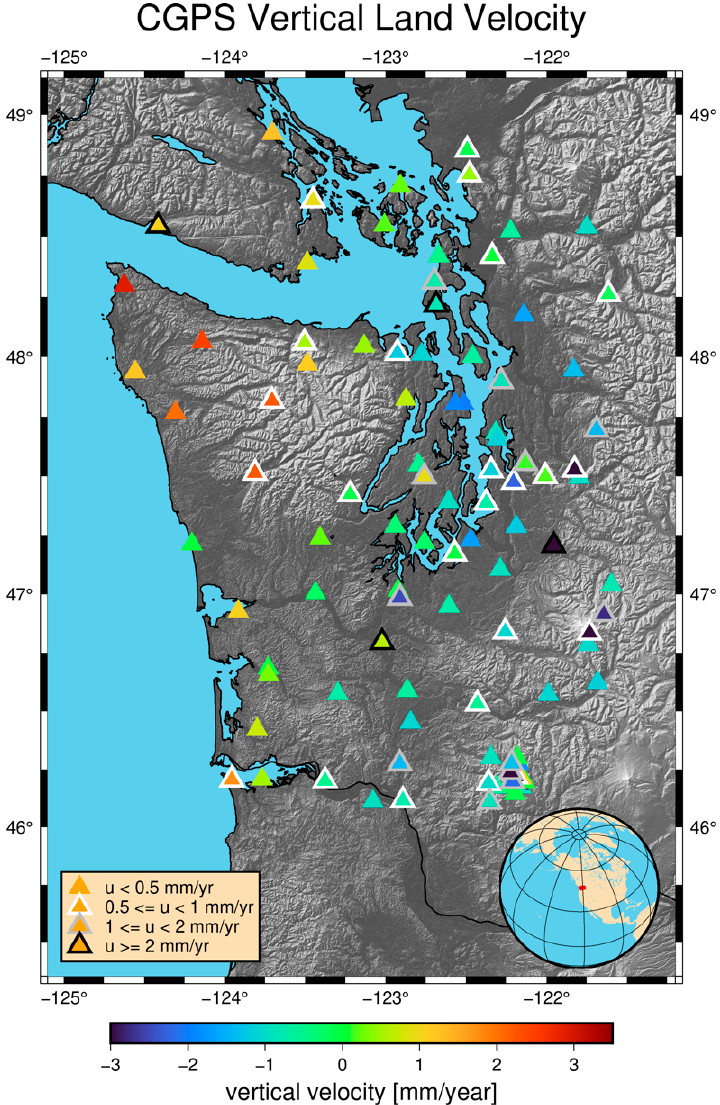
Figure 1. Continuous GNSS measurements of vertical land movement from five data providers. Vertical velocity is denoted by marker color and uncertainty is denoted by marker outline, expressed as millimeters per year (mm/yr). A transition from uplift, at the western tip of the Olympic Peninsula, to subsidence east is apparent in the CGNSS observations. Refer to Figure 2 for names of places. North is up.